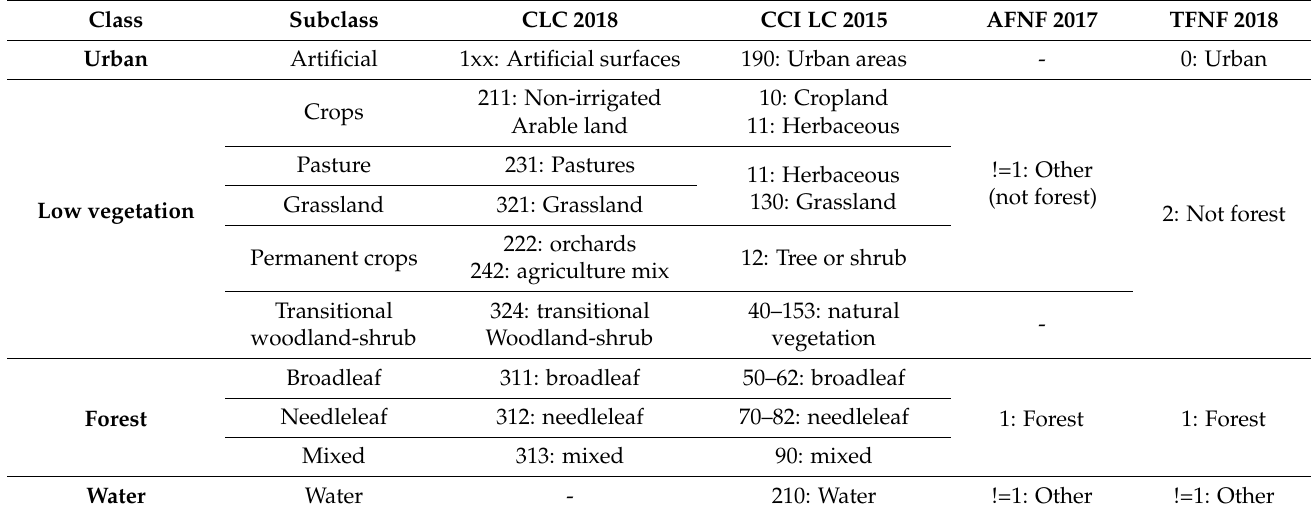
Table 1. Temperate site classification scheme together with the ruleset employed to determine the membership based on the preexisting datasets. The subclasses are based on agreement between CLC and CCI LC. GUF had to be 255 (urban) for the homonymous class, and 0 (other) for the rest of classes. “!=” denotes the NOT operator, i.e. “!=1” indicates not classified as forest in AFNF or TFNF.